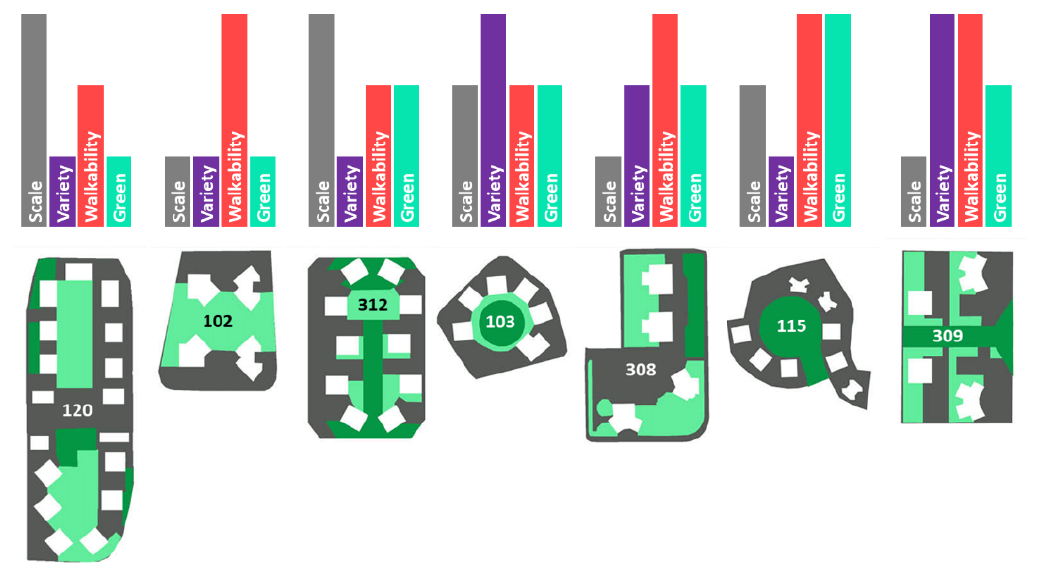
Figure 8. Green/gray nolli maps and the evaluation indexes of seven exemplary complexes.